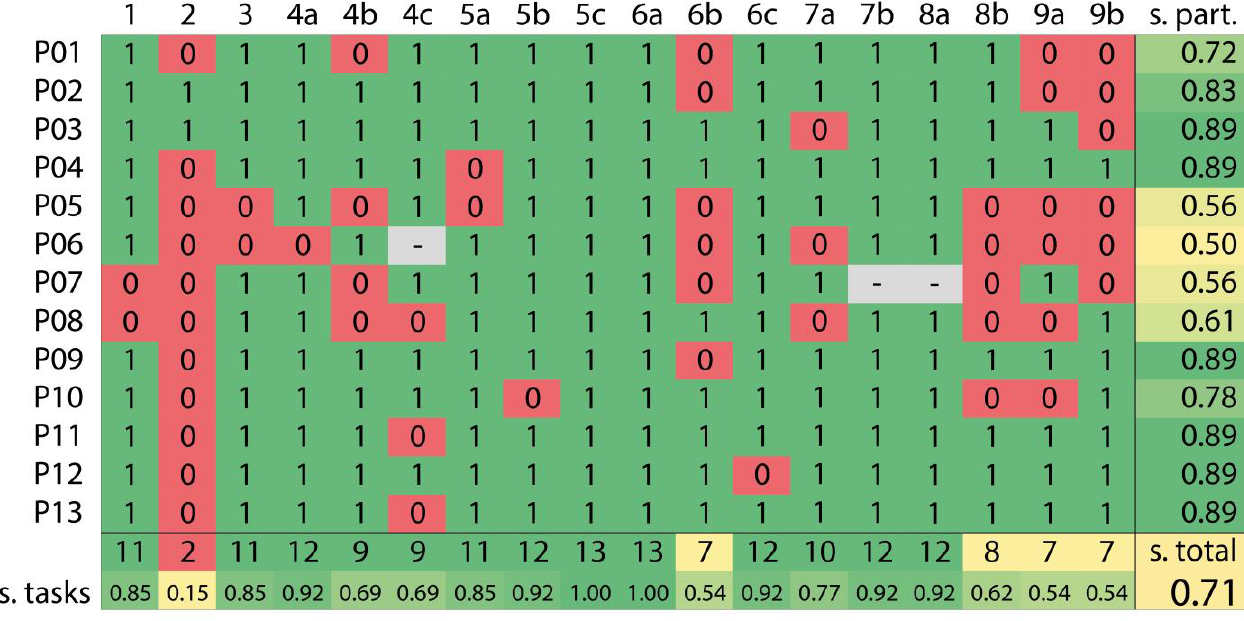
Figure 7. Task success rate and success score.